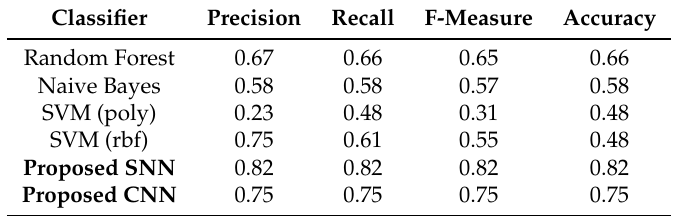
Table 6. Performance metrics for MR, where SVM (poly): Support Vector Machine using a polynomial kernel, SVM (rbf): Support Vector Machine using a radial basis function kernel.